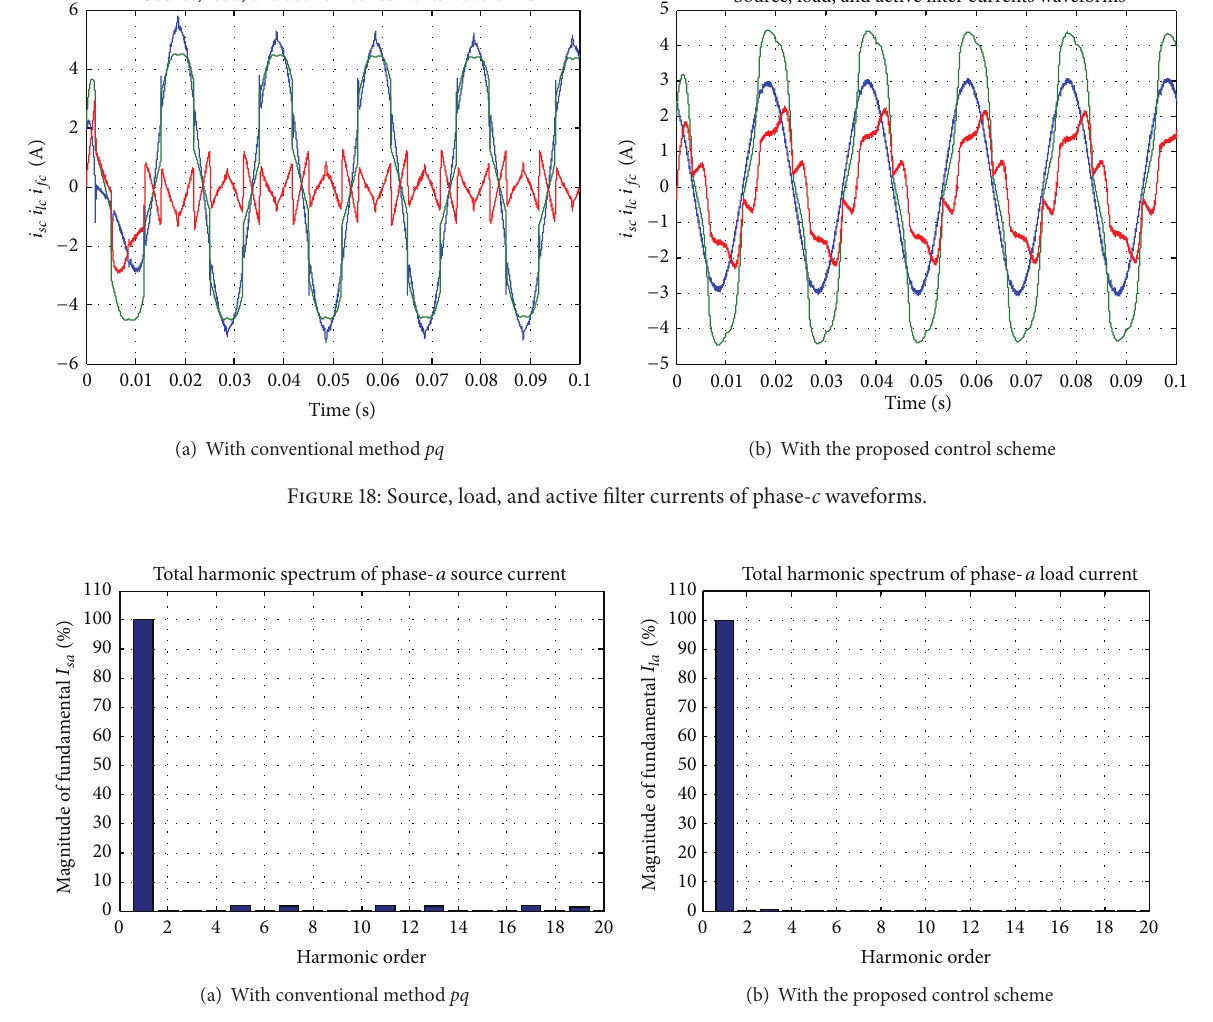
Figure 19: Frequency spectrum phase- a source current.